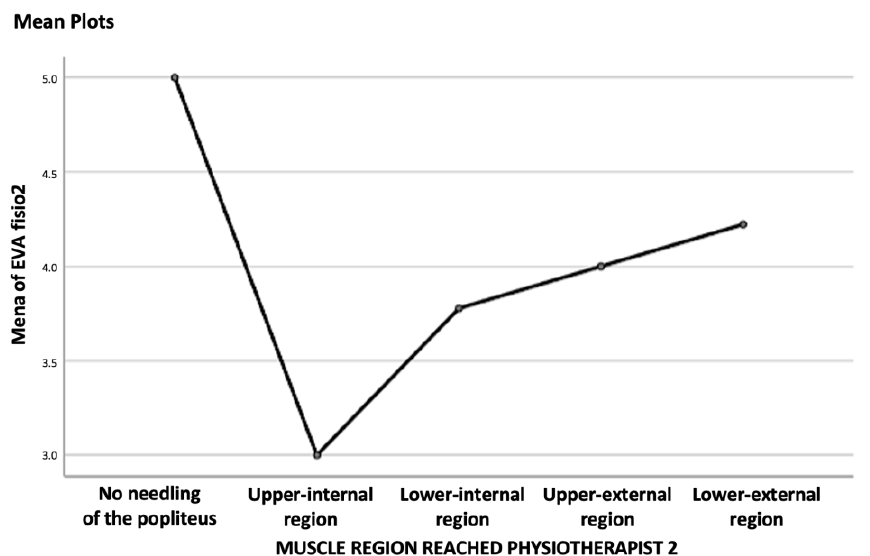
Figure 9. Line graph of the relationship between the VNS and the region of the punctured muscle for physiotherapist 2 .